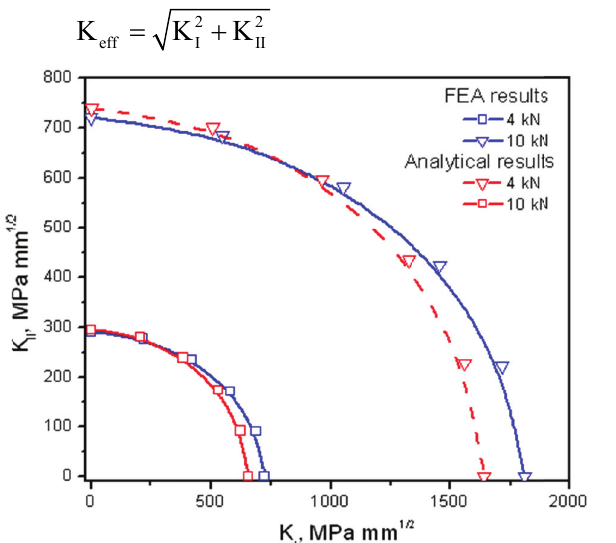
Figure 6: Variat finite element K eff vs .  (Fig.6 . This